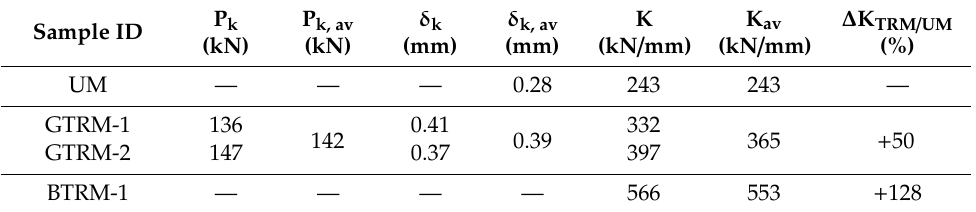
Table 8. Experimental results: knee loads, knee displacements and estimated stiffness results.